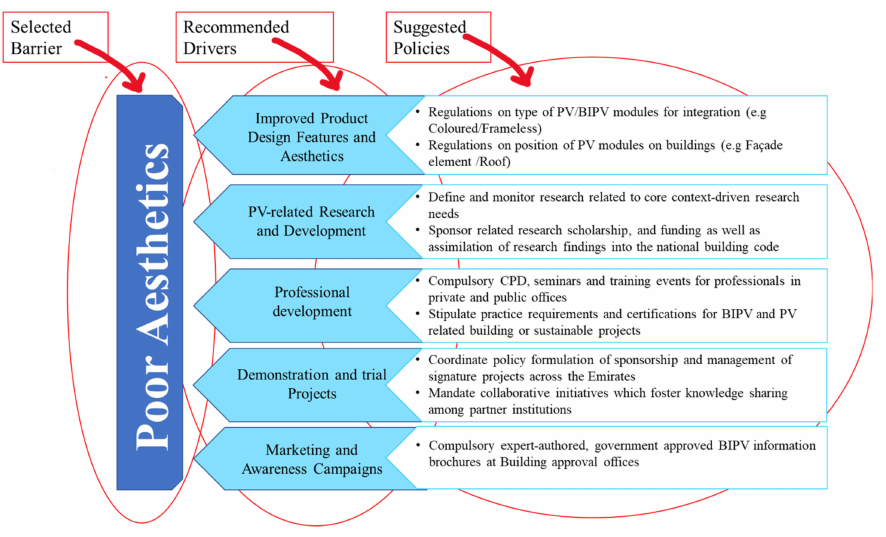
Figure 8. Resolving the poor aesthetics barrier using recommended drivers and suggested